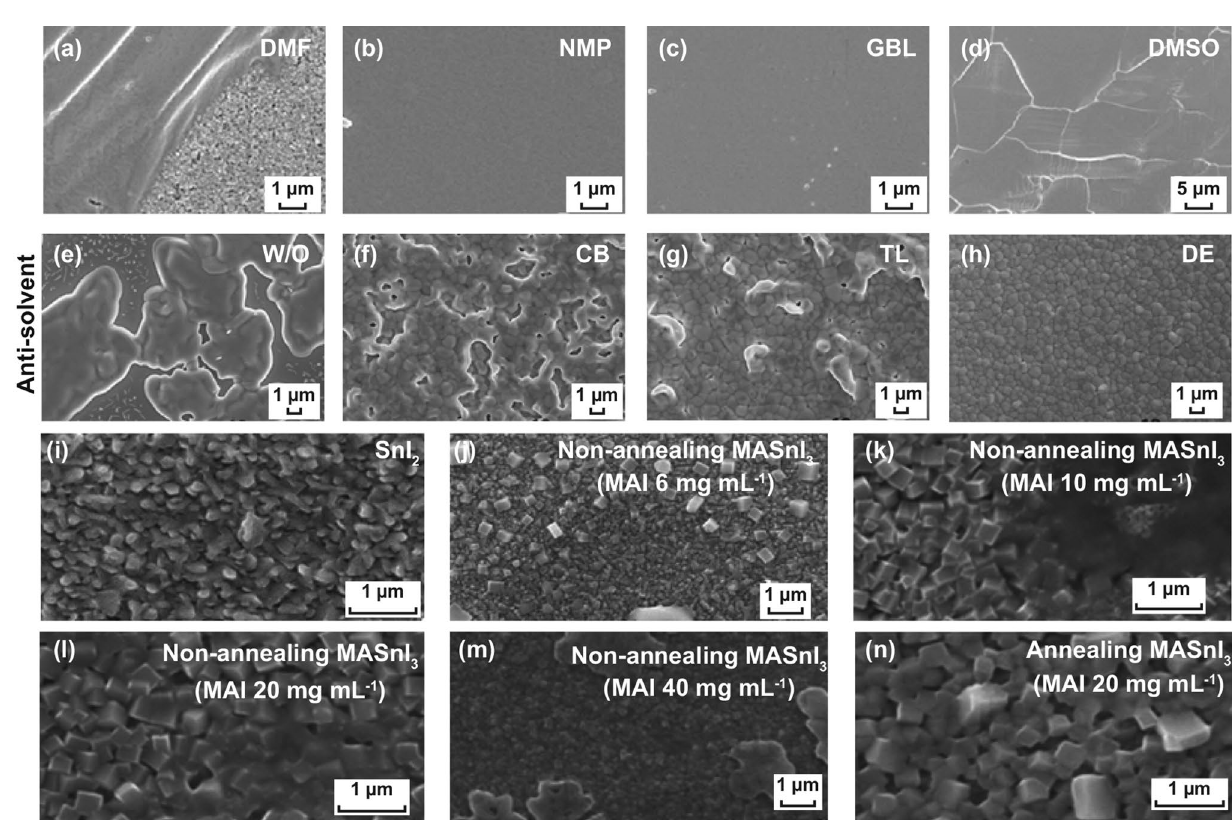
Fig. 3 SEM images for MASnI 3 layer on mesoporous TiO 2 layer by using a DMF, b NMP, c GBL, and d DMSO solvents. Reproduced with permission from Ref. [74]. SEM images for FASnI 3 films obtained from different antisolvent processes: e No dripping, f CB, g TL and h DE. Reproduced with permission from Ref. [96]. SEM images of i vapor deposited 100 nm SnI 2 , non-annealing MASnI 3 films with j 6, k 10, l 20 and m 40 mg mL −1 MAI precursor solution spin coated and n MASnI 3 films with 20 mg mL −1 MAI precursor solution spin coated followed by annealing at 80 °C for 10 min. Reproduced with permission from Ref.